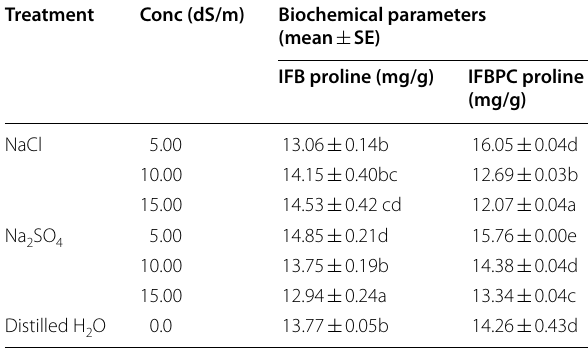
Means followed by different letters in the column are significantly different ( P < 0.05) from one another using Duncan’s new multiple range test (DNMRT)